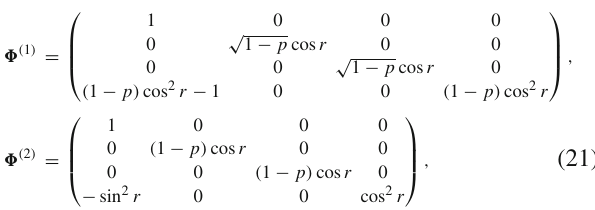
of (cid:4) AD , (cid:4) PD . In both cases, the mapping matrices can be obtained